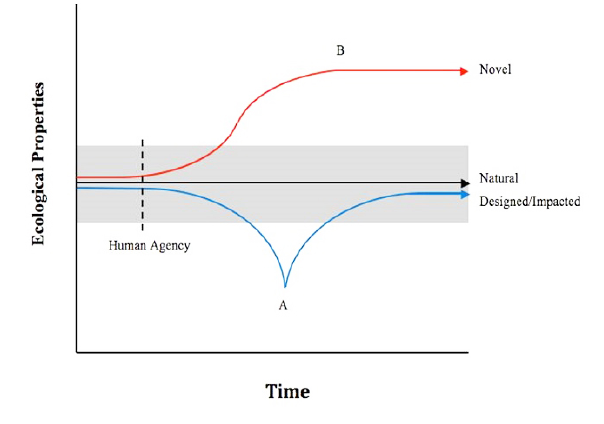
Fig. 1 . The middle trajectory represents a self-sustaining natural succession, where the upper and lower boundaries of the gray box represent natural variability. The dashed line represents an act of human agency triggering a threshold crossing that alters the successional trajectory of the ecosystem, resulting in a novel ecosystem in the case of the upper trajectory and an impacted or designed ecosystem in the case of the lower trajectory. Point A represents the removal of human agency, causing the ecosystem to revert back to its prior trajectory as is the case in designed or impacted ecosystems. Alternatively, the removal of human agency could result in a novel ecosystem if that ecosystem can become self-sustaining. Point B is the point at which the novel ecosystem reaches a self-sustaining state that continues on a trajectory that will not realign with its previous